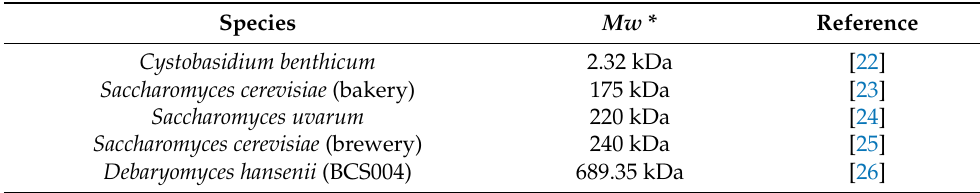
Table 1. Molecular weights of β -glucans from different yeast species.